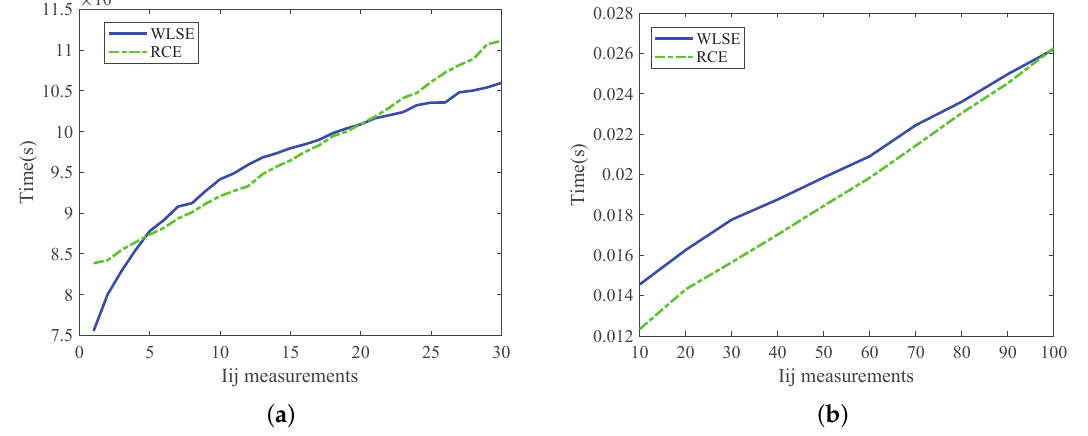
Figure 6. Average computational cost: ( a ) 85-bus system; ( b ) 117-bus